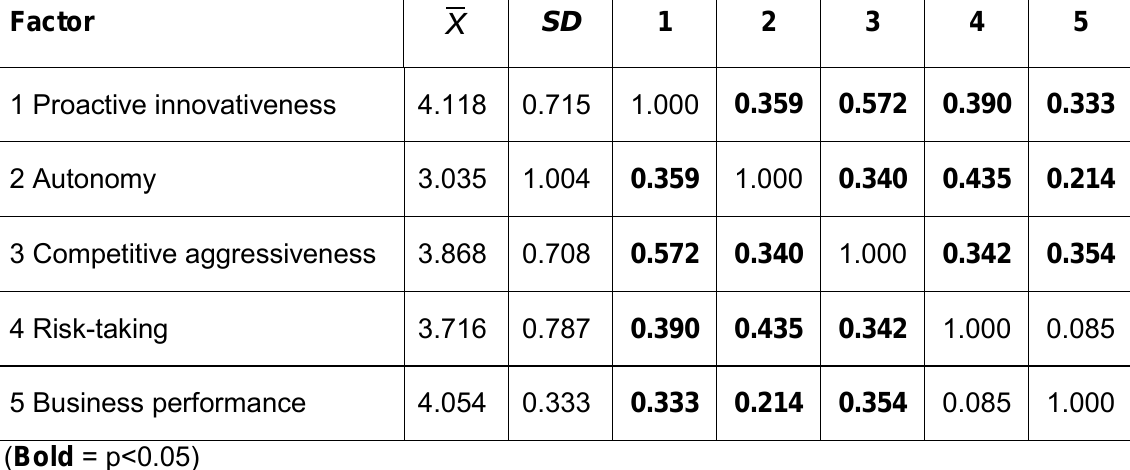
DESCRIPTIVE STATISTICS AND CORRELATIONS BETWEEN FACTORS